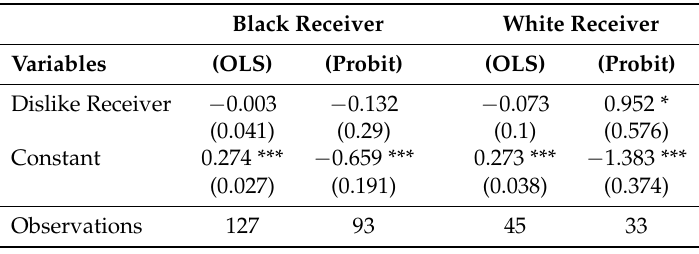
Table 6. Discrete estimations, conditional on the race of the